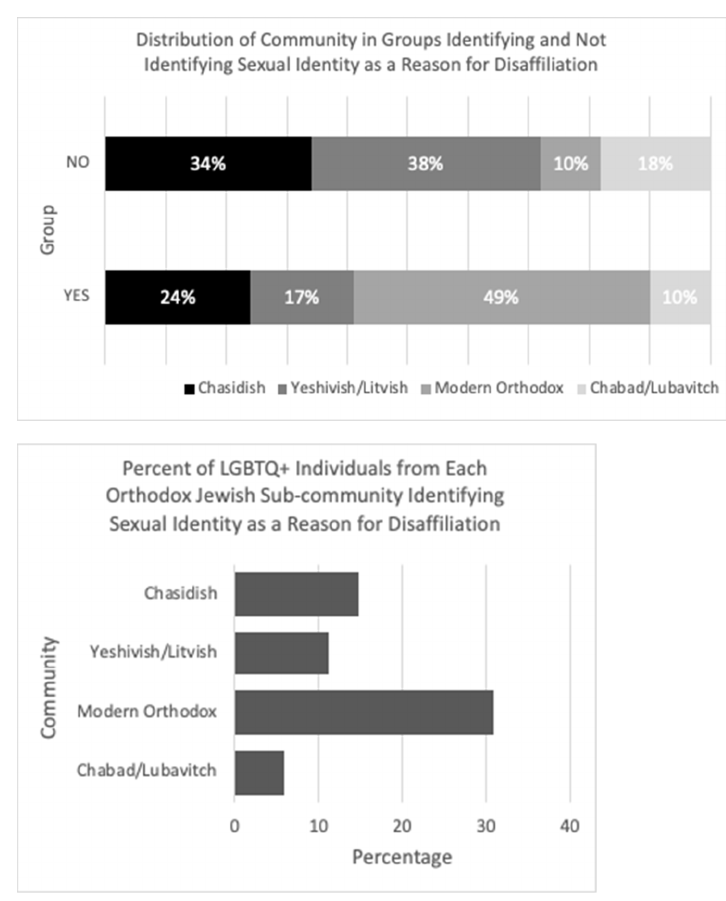
Figure 1. ( top ) Community identity distribution for individuals who did and did not identify sexual identity and/or religious views on homosexuality as a cause or initial trigger for disaffiliation and ( bottom ) percentage of individuals in each community identity group who identified sexual iden- tity and/or religious views on homosexuality as a cause or initial trigger for disaffiliation. For those individuals who did not cite sexual identity and/or religious views on ho- mosexuality as contributors to disaffiliation, we examined the most frequently reported causes and triggers. This sample reported triggers and causes of disaffiliation similar to those reported in the larger study of 387 disaffiliates, which included 268 individuals who did not identify as LGBTQ+. Figure 2 displays the proportion of LGBTQ+ individuals cit- ing each of a variety of categories as triggers and causes of their disaffiliation.